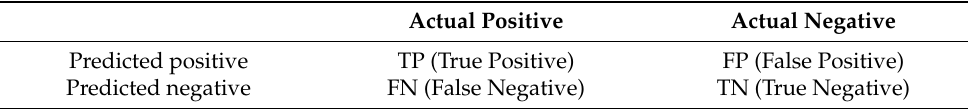
Table 6. Positive case and negative case definitions of items to be